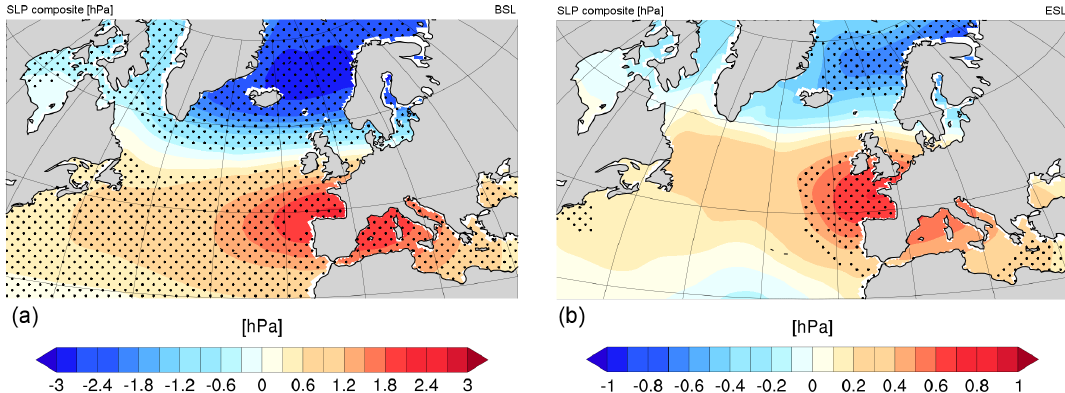
Figure 9. Composite gridded winter SLP anomaly for periods of high BSL (a) and ESL (b) at Cuxhaven. Stippling marks areas significant at the 5% confidence level.